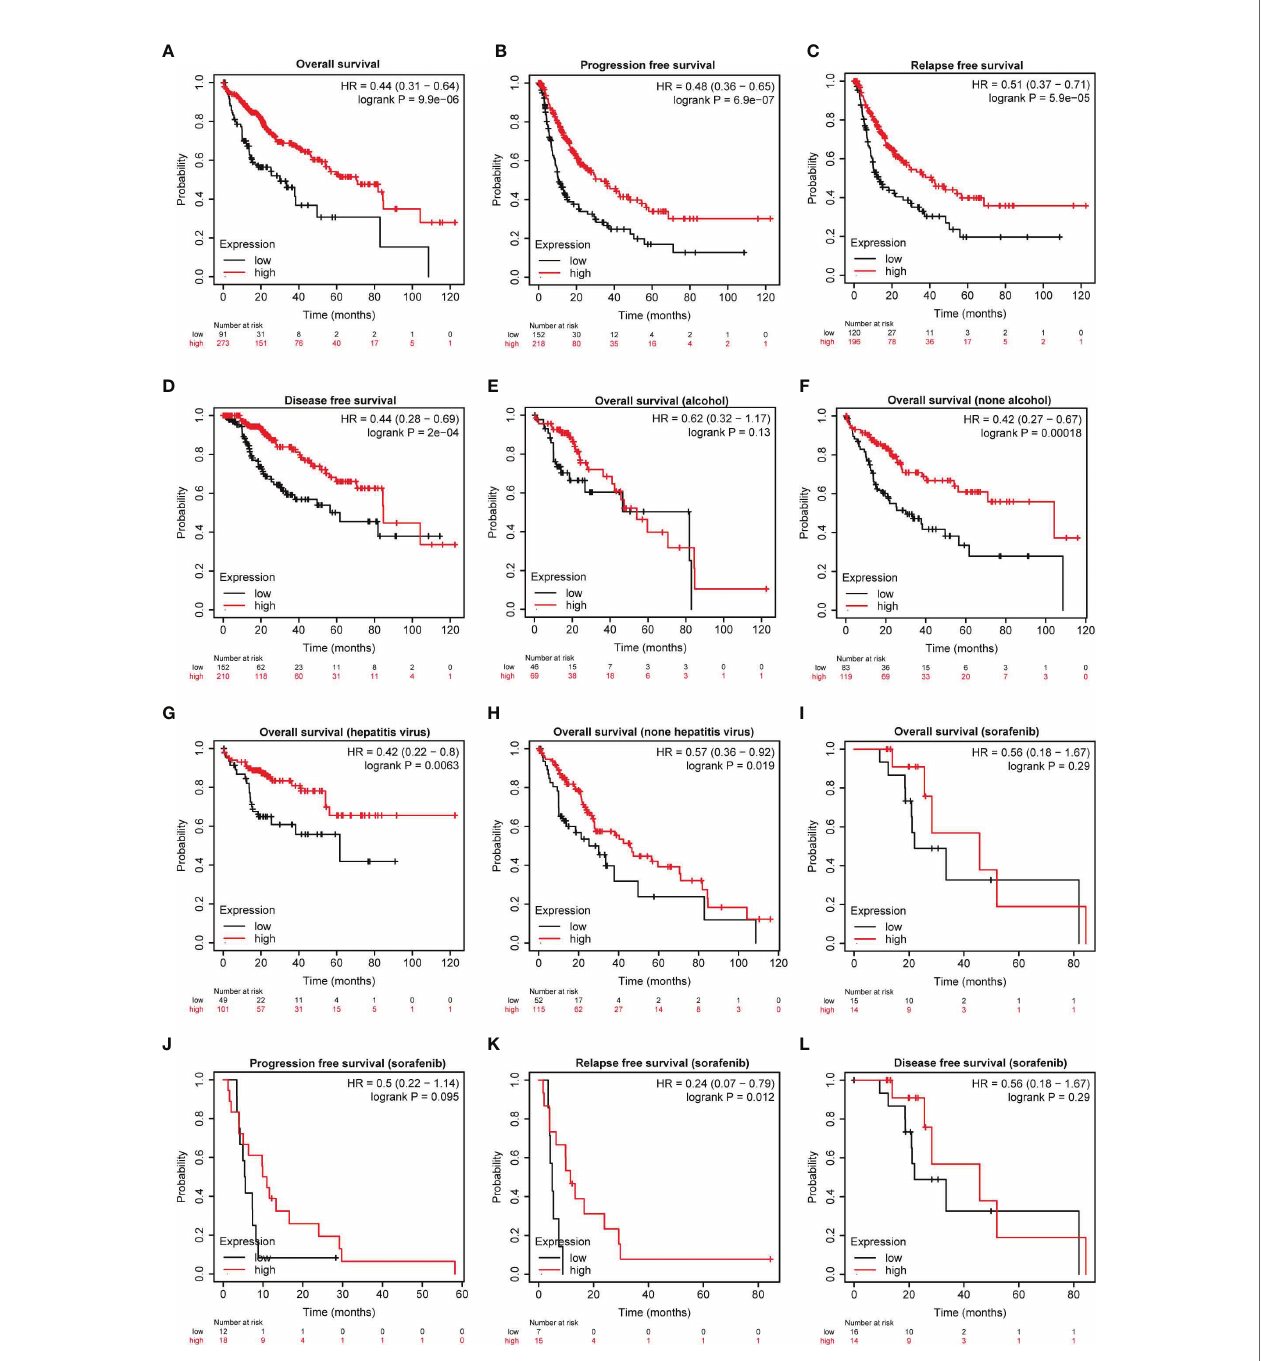
FIGURE 2 | Serpinc1 protein expression is correlated with outcomes in hepatocellular carcinoma patients. (A – D) Analysis of the correlation between the serpinc1 expression and survival rate in hepatocellular carcinoma patients from Kaplan-Meier Plotter database. Overall survival (A) , Progression-free survival (B) , Relapse-Free survival (C) , and Disease-free survival (D) . (E, F) Analysis of the effect of alcohol and serpinc1 expression on the outcomes from Kaplan-Meier Plotter database. Alcohol (E) and none alcohol (F) . (G, H) Detection of the effect of Hepatitis virus and serpinc1 expression on the outcomes from Kaplan-Meier Plotter database. Hepatitis virus (G) and none hepatitis virus (H) . (I – L) Analysis of the effect of serpinc1 expression and sorafenib administration on outcomes of hepatocellular carcinoma patients from Kaplan-Meier Plotter database. Overall survival (I) , Progression-free survival (J) , Relapse-Free survival (K) , and Disease- free survival (L)